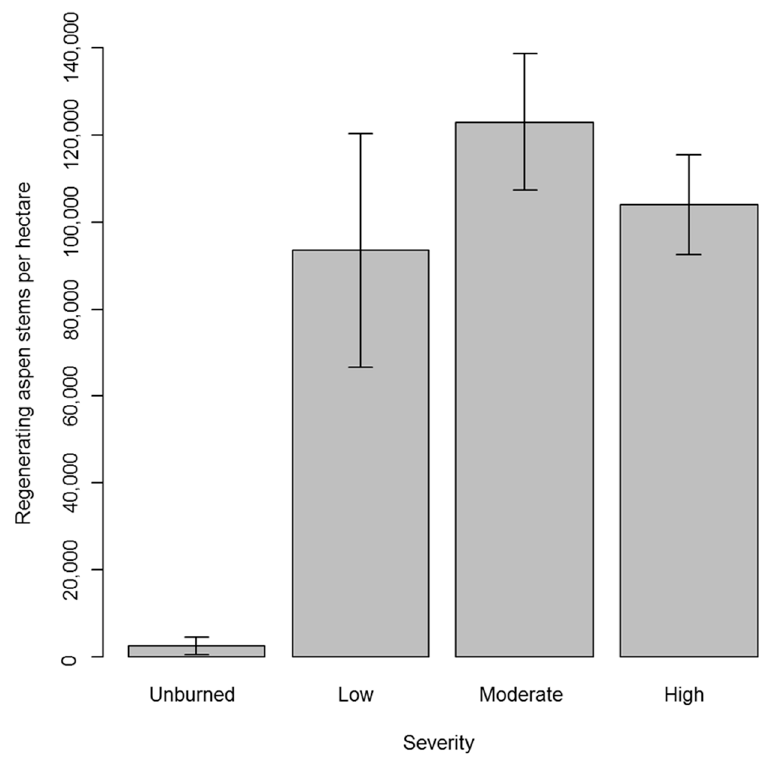
Figure 5. Aspen regeneration (stems per hectare) across the three fire severities (low, moderate, and high) and in unburned stands. Values are mean and standard error.